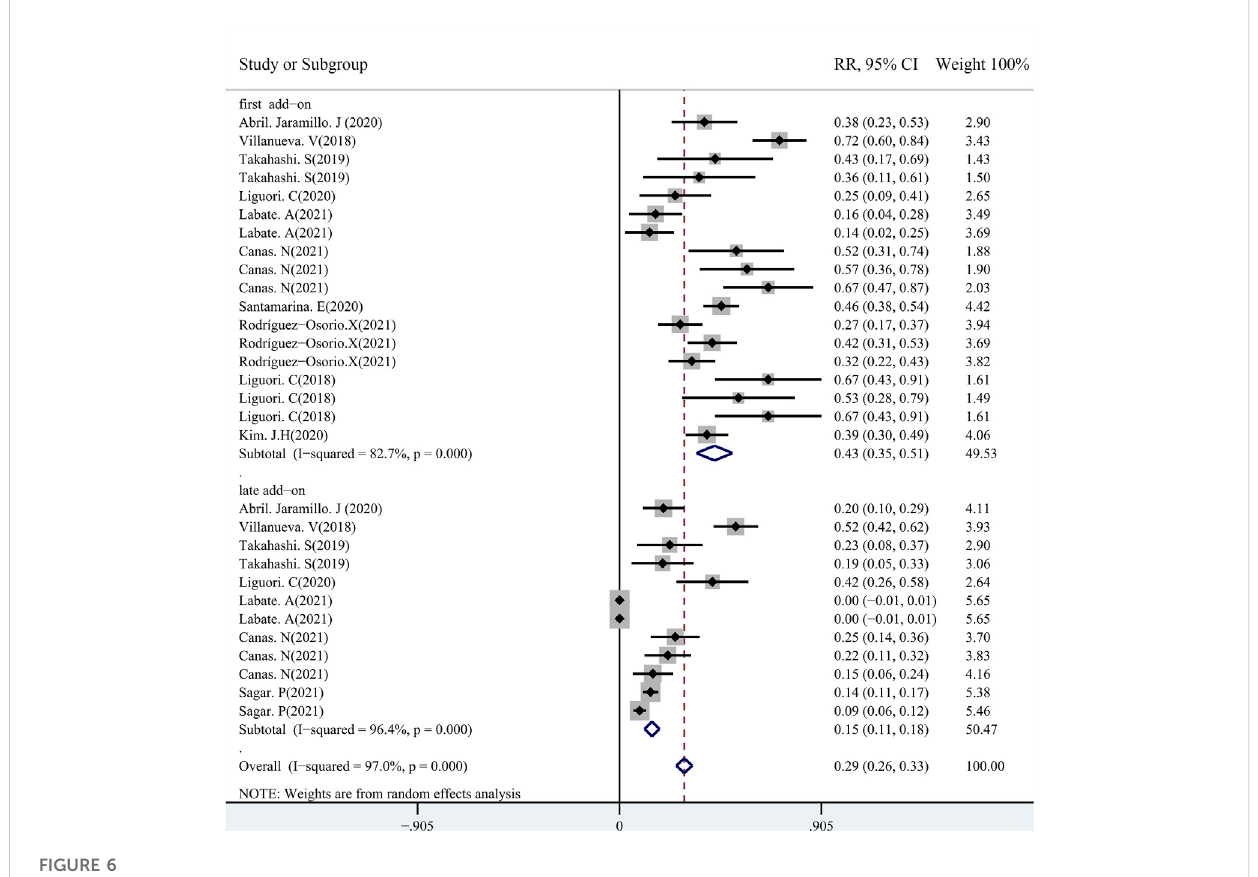
FIGURE 6 Pooled seizure-free rate ( fi rst vs . second add-on).